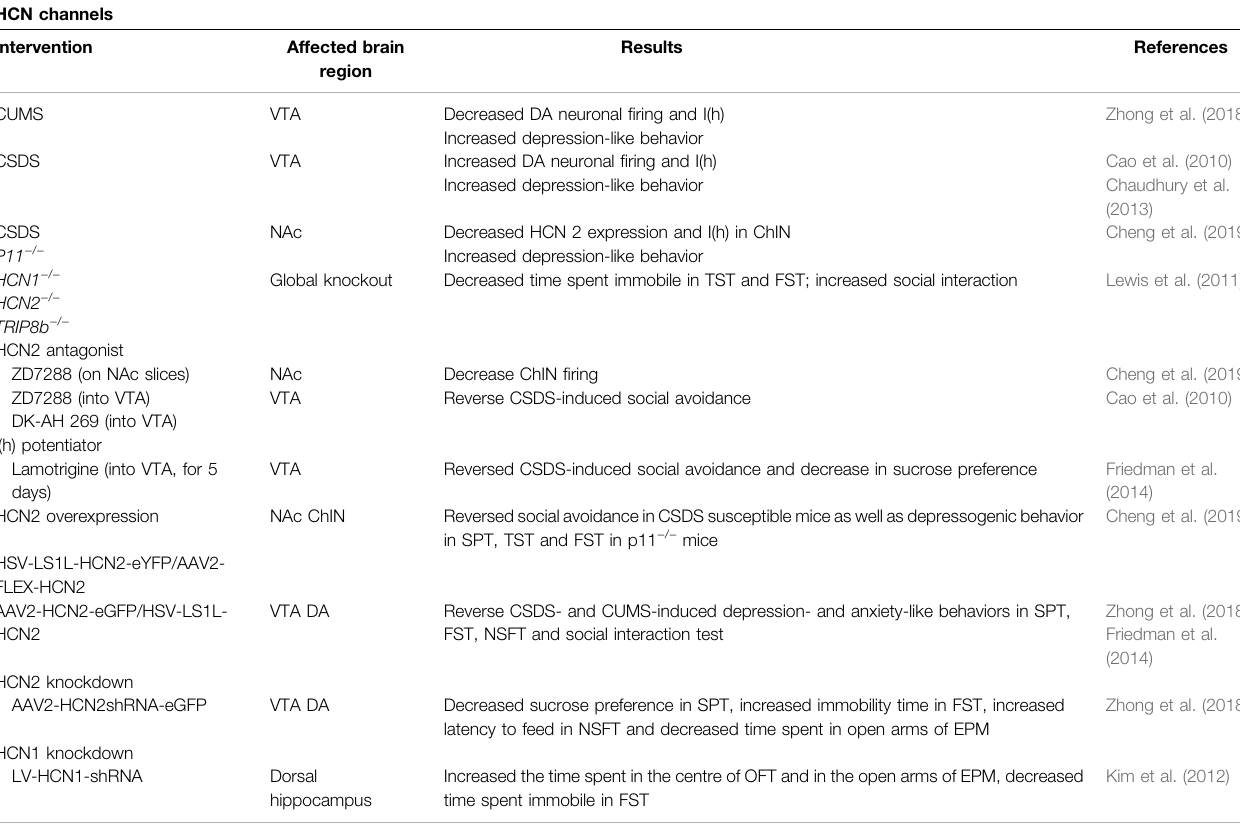
TABLE 2 | Effects of modulating HCN2 expression and function on depression-like